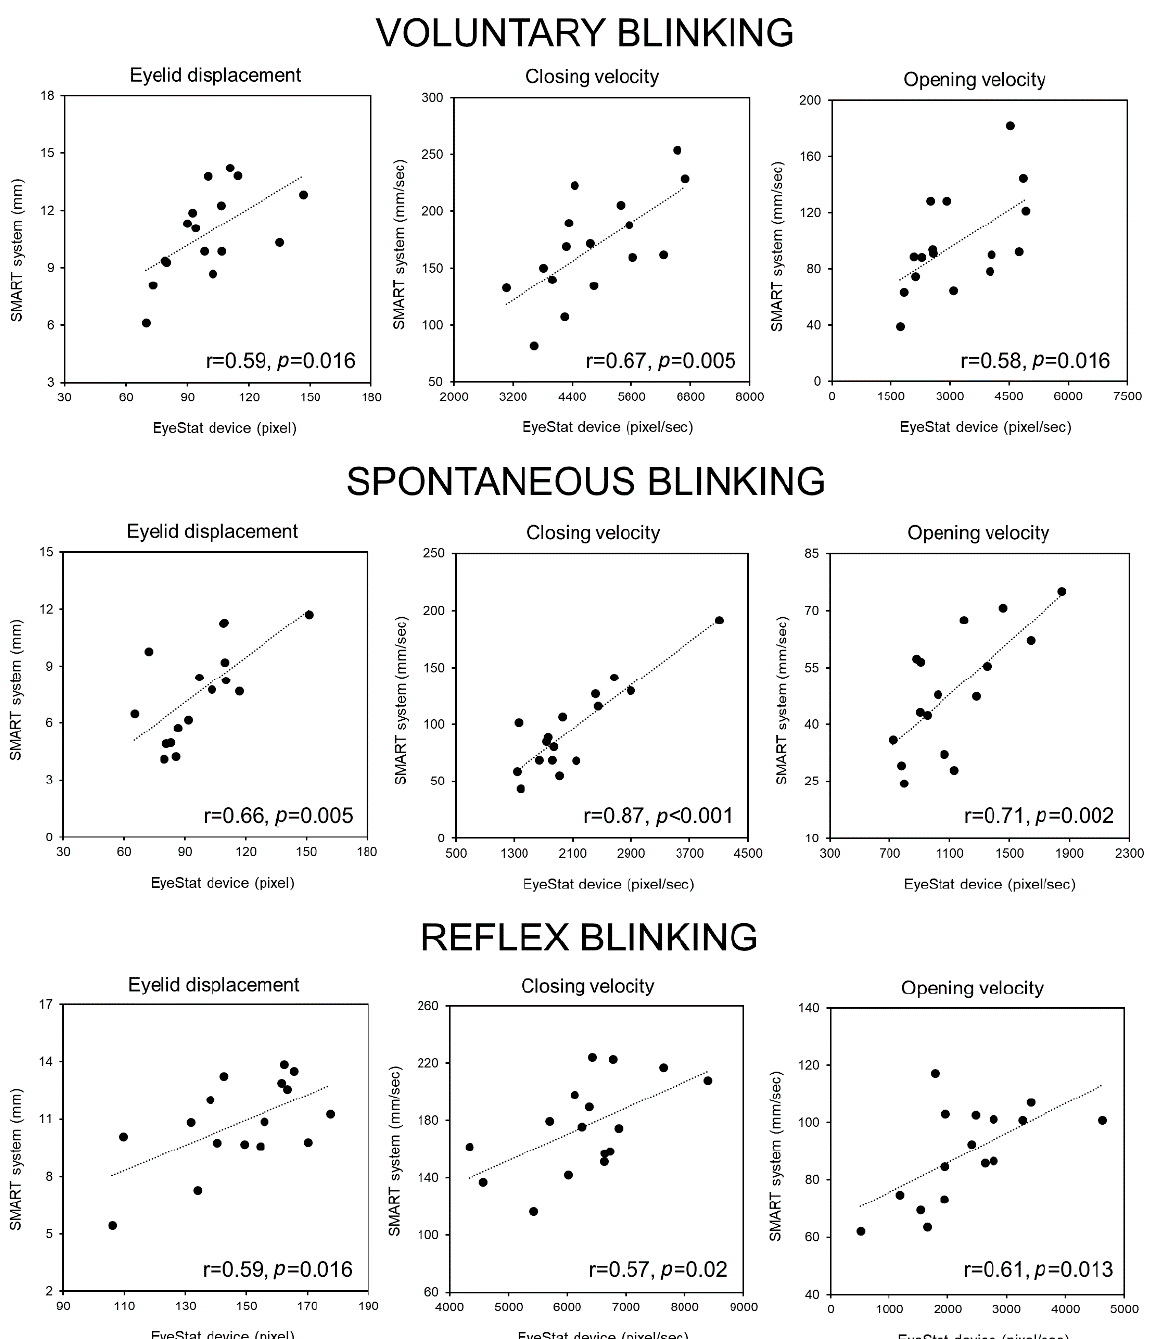
Figure 2. Correlations between the various blinking parameters measured with the two different methodologies. The amount of eyelid displacement and the velocity of the closing and opening phases of blinking measured with the EyeStat device during voluntary (top row), spontaneous (middle row), and reflex blinking (bottom row) significantly correlated with values of the same measures obtained using the SMART system (r and p values are depicted in the lower right